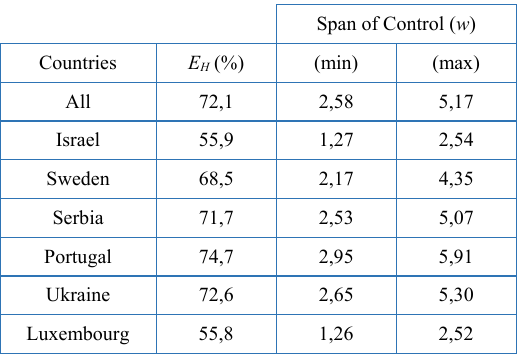
Table 7. Relationship between E H and span of control for several